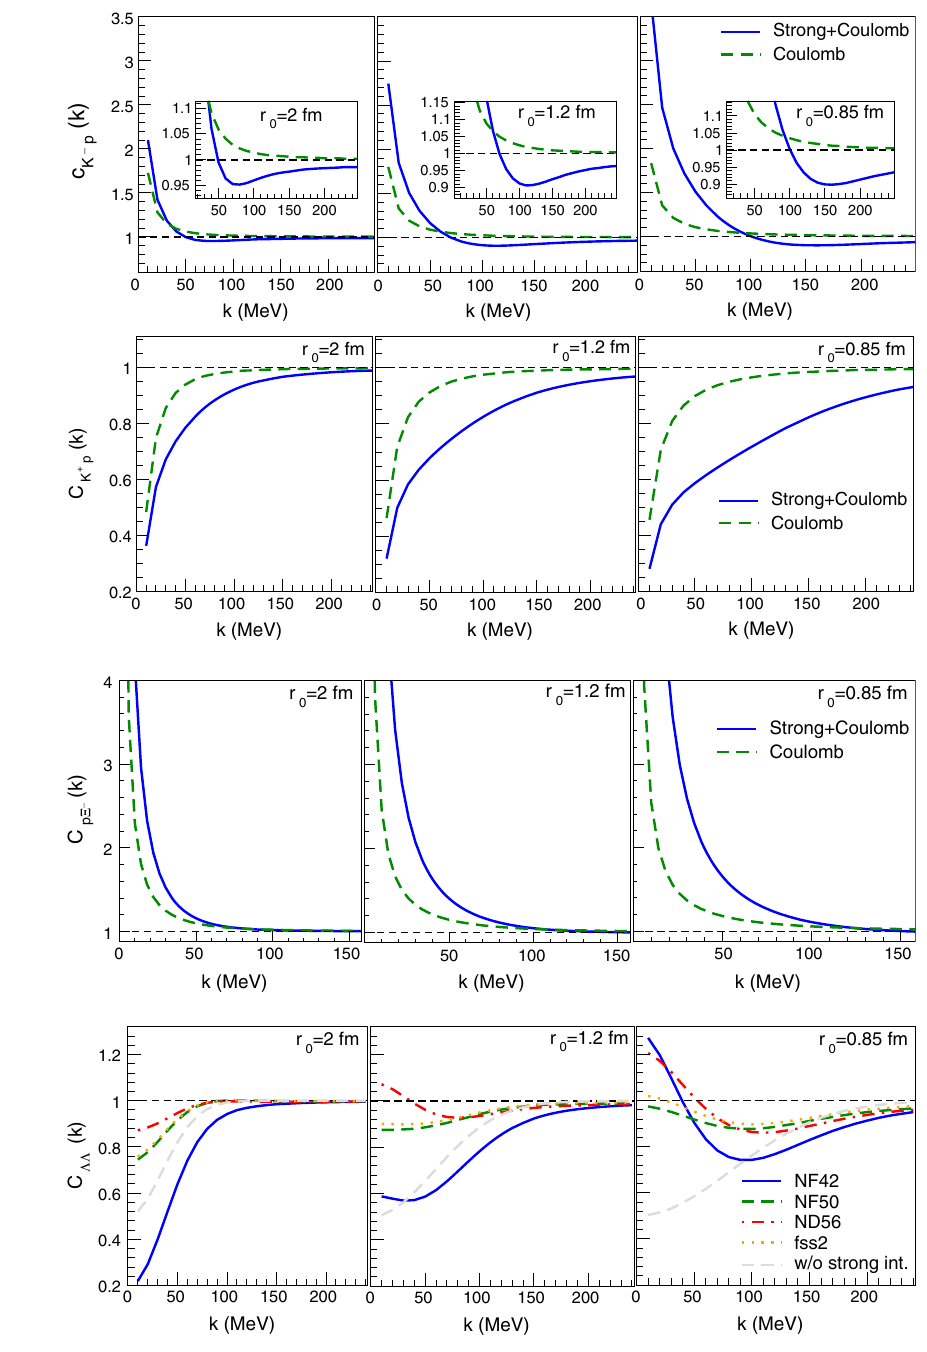
be explained easily by looking at the potentials shown in Fig. 4 and their corresponding scattering parameters listed in Table 2. The most binding potentials, NF42 and ND56, lead to a correlation function that is significantly enhanced for smaller sources as it becomes sensitive to the deep attrac- tive contribution. The weakly attractive potentials, NF50 and fss2, also show an enhancement compared to the quan- tum statistics baseline, nevertheless the correlation signal